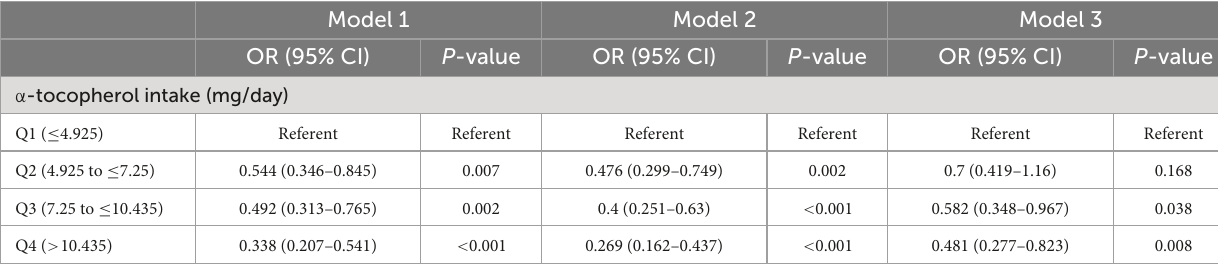
TABLE 7 Associations of quartile of α -tocopherol intake with periodontitis defined by EWP definition.